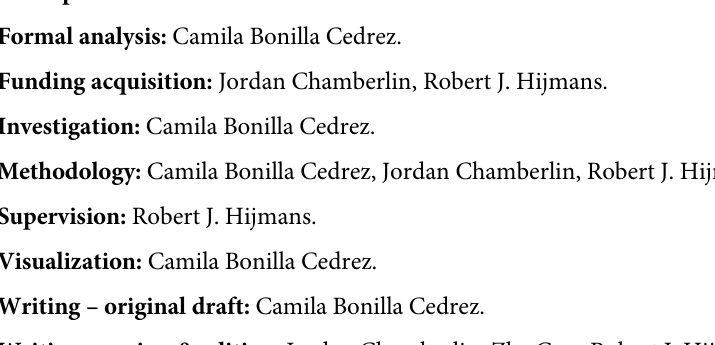
S2 Fig. Non-subsidized DAP price (USD kg -1 ) versus non-subsidized urea price (USD kg -1 ) for location where both urea prices were reported in each country. (DOCX) S3 Fig. Non-subsidized CAN price (USD kg -1 ) versus non-subsidized urea price (USD kg -1 ) for location where both urea prices were reported in each